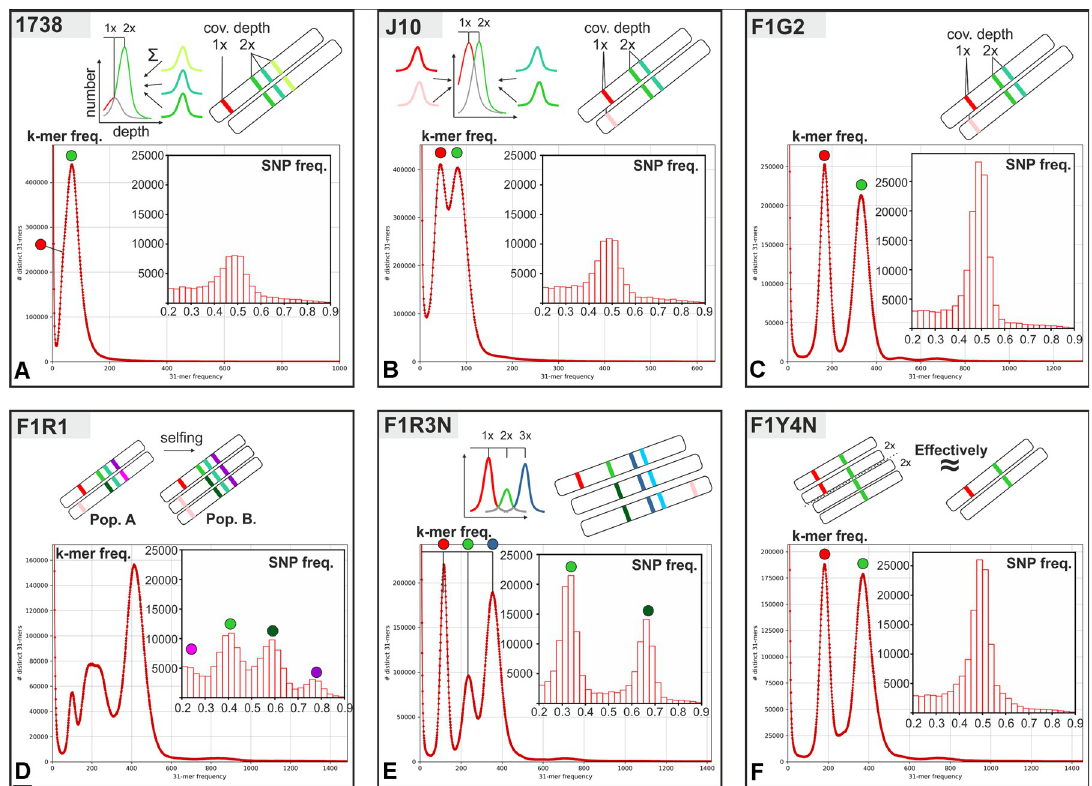
Fig 1. K-mer and SNP analyses reveal ploidy and heterozygosity of hybrid clones. Unassembled reads from parents (1738 and J10) and hybrid progeny (F1G2, F1R1, F1R3N, F1Y4N) were analysed by k-mer and SNP frequency; the plots are linked schematically to coverage depth via a genome model in the inset cartoons. The k-mer frequency plots show the number of k-mers with a specific coverage depth; equally spaced peaks correspond to multiples of k-mer incidence within the whole genome. The SNP frequency plots show the number of detected heterozygous SNPs within the core chromosomal regions, excluding VSG s in subtelomeric regions, and their relative observed allele frequency (proportion of observed reads with alternate value). Inset cartoons illustrate the inheritance of loci on one pair of homologues, linked by coloured dots to particular peaks on the frequency plots. Our working hypothesis is that F1R1 is a mixture of the original F1R1 clone (population A) and a selfed, possibly triploid, population (population B) formed during fly transmission of F1R1 after its original isolation; the 0.2:0.8 peak ratio is produced by chromosomal crossing over (see text for further